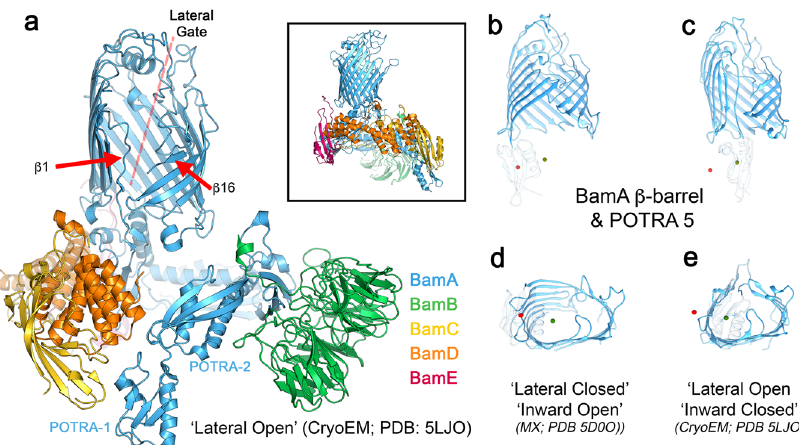
Fig. 1 Structure of BAM highlighting its lateral gate. a Cryo-EM structure (PDB 5LJO) 15 of detergent (DDM)-solubilised BAM in the ‘ lateral open ’ conformation. The β -strands 1 and 16 and the lateral gate are indicated. Inset: the crystal structure (PDB 5D0O) 13 of BAM in the ‘ lateral closed ’ conformation. b The conformation of the BamA β -barrel and position of POTRA5 in the ‘ lateral closed ’ X-ray structure (pdb 5D0O) 13 and c ‘ lateral open ’ cryo-EM structure (pdb 5LJO) 15 . The centres of mass of POTRA5 for both conformations are marked with red (lateral closed) and green (lateral-open) spheres in each panel. d , e Bottom (periplasmic) view of the d lateral closed and e lateral-open conformations of BAM showing the different shape of the β - barrel. As in panels b and c , centres of mass for POTRA5 in both conformations are marked in each panel. POTRA domains 1 – 4 and the lipoproteins (BamB – E) have been removed in panels ( b ) through ( e ) for clarity.